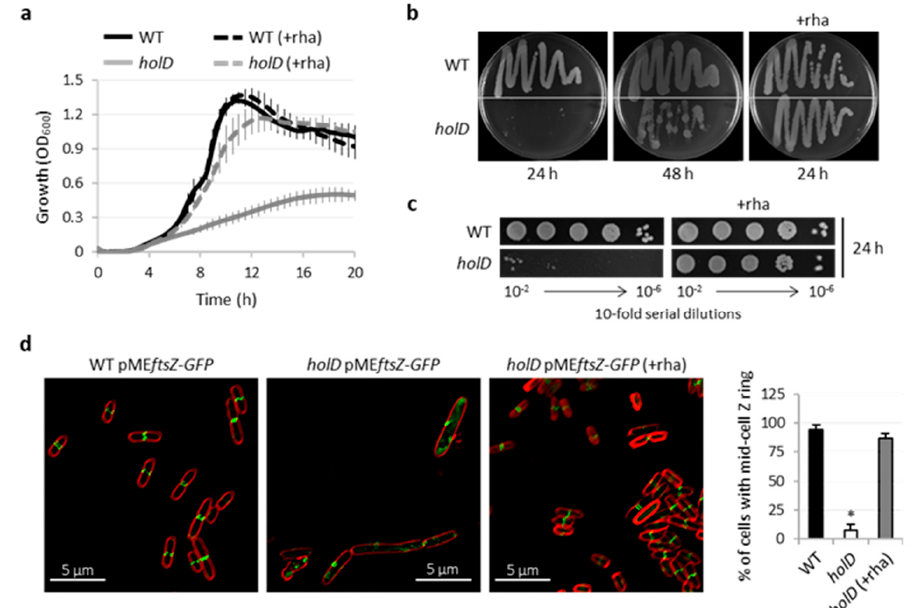
Figure 2. Effect of HolD depletion in P. aeruginosa . ( a ) Growth curves of the P. aeruginosa wild-type (WT) strain PAO1 and the holD conditional mutant ( holD ) at 37 ◦ C in MH supplemented or not with 0.01% rhamnose (+rha). Data are the mean ( ± SD) of three independent assays. ( b ) Growth and ( c ) plating efficiency of PAO1 and holD on MH agar plates supplemented or not with 0.01% rhamnose (+rha) after 24 and/or 48 h of incubation at 37 ◦ C. ( d ) Confocal microscopy images of PAO1 and holD expressing the fusion protein FtsZ-GFP cultured in the presence of 0.003 mM IPTG and, when indicated, 0.01% rhamnose (+rha), and stained with the membrane dye FM4-64. The graph on the right shows the percentage of cells showing mid-cell localization of the FtsZ-GFP fusion protein for PAO1, holD and holD cultured in the presence of rhamnose (+rha). Data are the mean ( ± SD) of three independent experiments, and at least 50 cells were analyzed per sample and experiment. The asterisk indicates a statistically significant difference ( p < 0.05) with respect to the WT strain. Images in panels ( b – d ) are representative of at least three independent